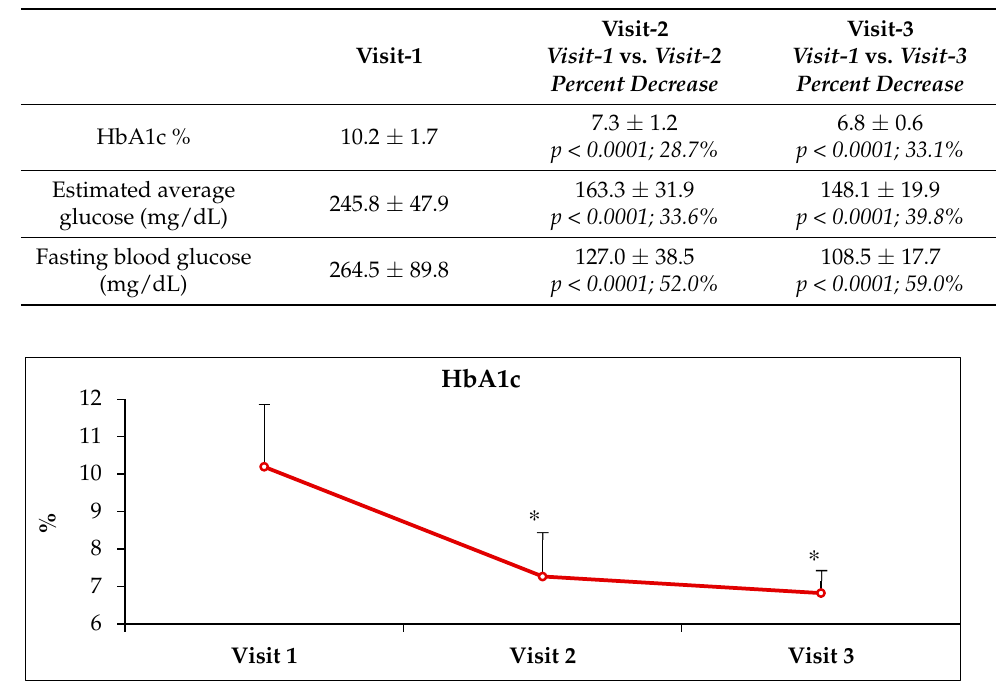
Table 1. Glycemic indices. Values are means ± SD; means are statistically different at p < 0.05. Visit-1 = first visit where ABCDE was provided; Visit-2 and Visit-3 = visits 3- and 6 months after Visit-1.